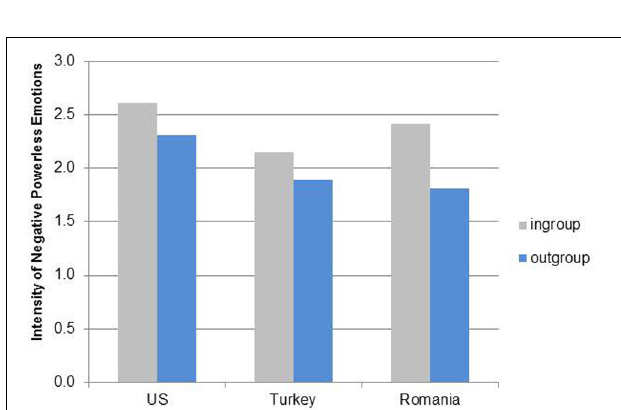
FIGURE 5 | Means of intensity of negative powerless emotion expressions for cultural group and social context (ingroup/outgroup